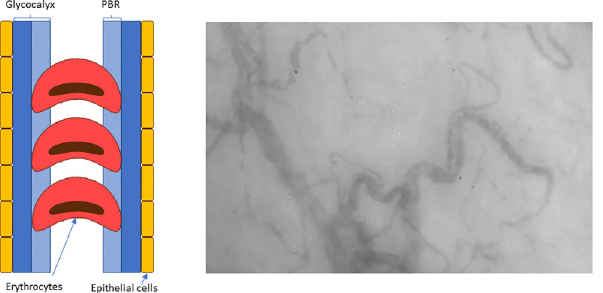
Fig 1. Schematic representation of the lateral movement of erythrocytes and image of measured